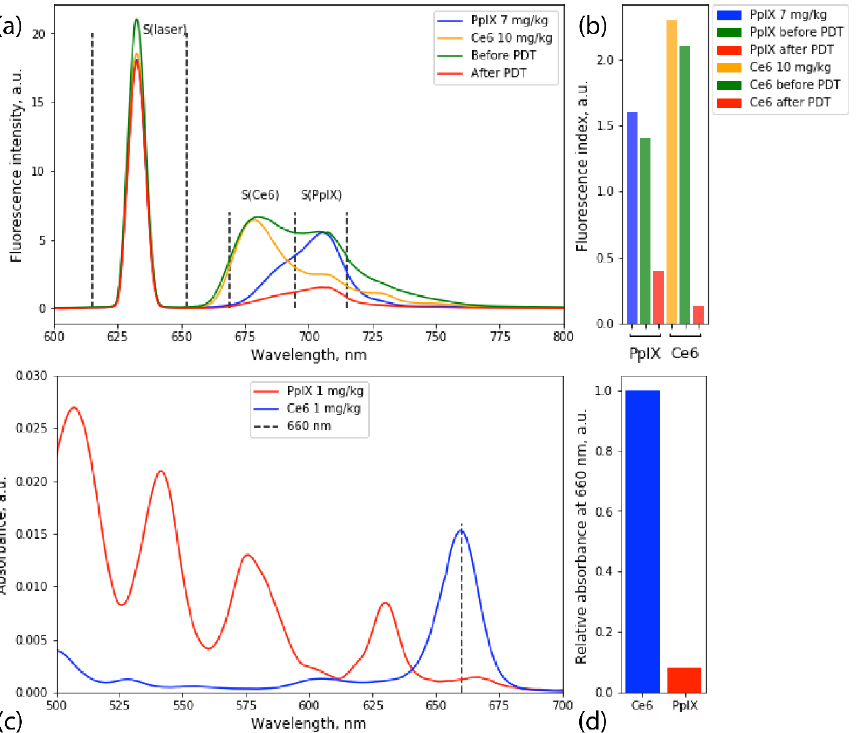
Figure 5. Fluorescence emission spectra of PpIX and Ce6 recorded before and after PDT and fluorescence spectra of prepared optical phantoms ( a ). Fluorescence indices histogram of PpIX and Ce6 in optical phantoms and accumulated in tumor tissue before and after PDT. Fluorescence index for PpIX and Ce6: S(Ce6 or PpIX)/S(laser). Correlating fluorescence indices, PpIX concentrations before and after PDT were 6 and 1.4 mg/kg, respectively; for Ce6, 9 and 0.6 mg/kg, respectively ( b ). Absorption spectra of Ce6 and PpIX at 1 mg/kg concentration ( c ). Relative absorbance of Ce6 and PpIX at 660 nm ( d ).